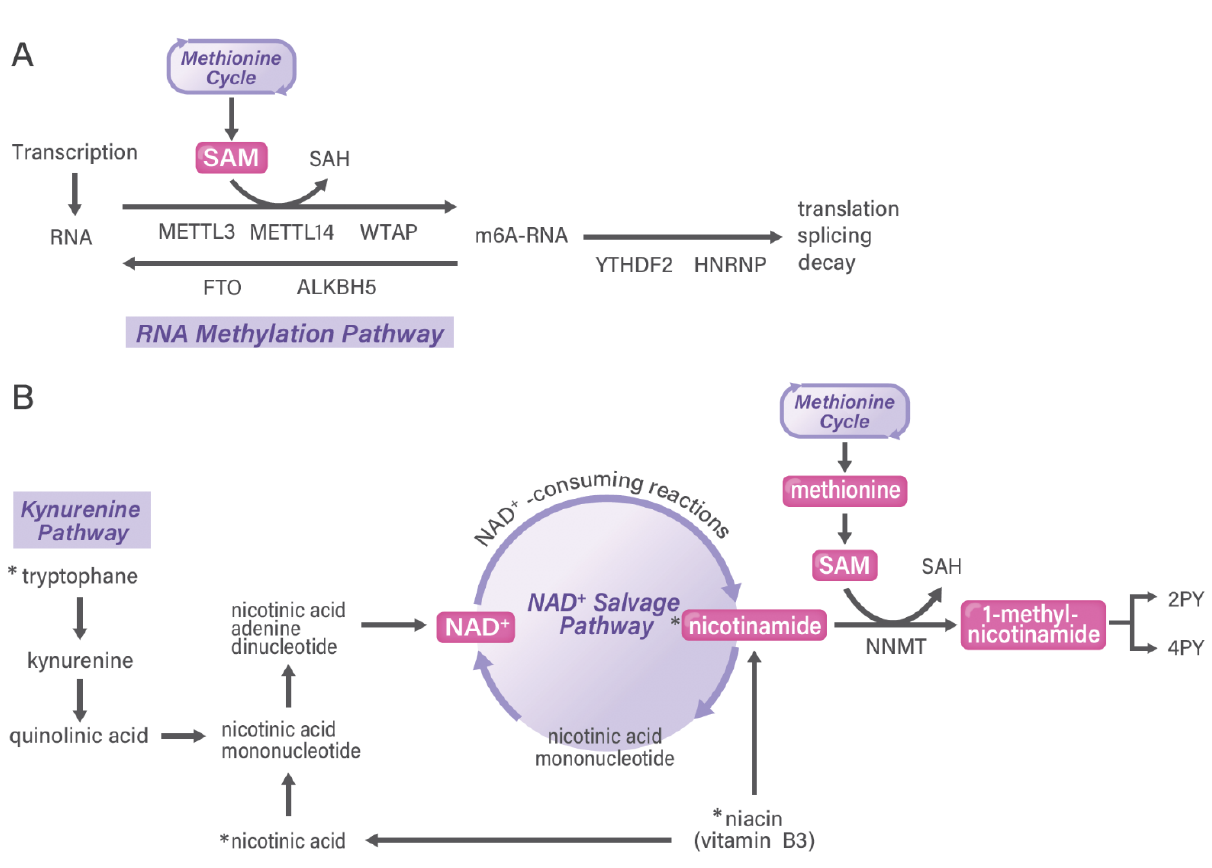
Figure 4. RNA methylation pathway and NAD+ salvage pathway in cancer. In tumor tissues, heterogeneous cell populations exert differential functions of the RNA methylation pathway ( A ) and the NAD+ salvage pathway ( B ), which are examples of the methylosystem. Nicotinamide metabolism is shown as the NAD+ salvage pathway in the correlation of the kynurenine pathway and the one-carbon pathway. Although NAD+ can be synthesized from tryptophan in the kynurenine pathway, this metabolic pathway is less effective in humans than in mice. 2PY, N-methyl-2-pyridone-5-carboxamide; 4PY, N-methyl-4-pyridone-3-carboxamide; NAD+, nicotinamide adenine dinucleotide; SAM, S-adenosylmethionine; SAH, S-adenosyl-homocysteine. Asterisks indicate dietary intake. Asterisks (*) indicate ones from diet.